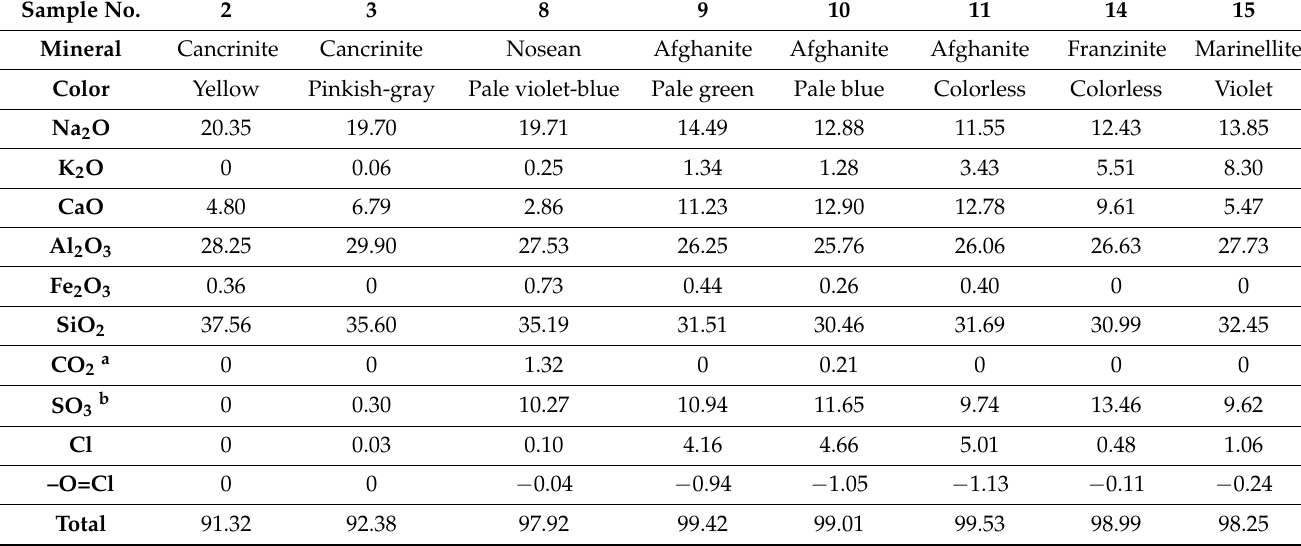
Table 1. Chemical composition of CRAs (wt.%) obtained in this